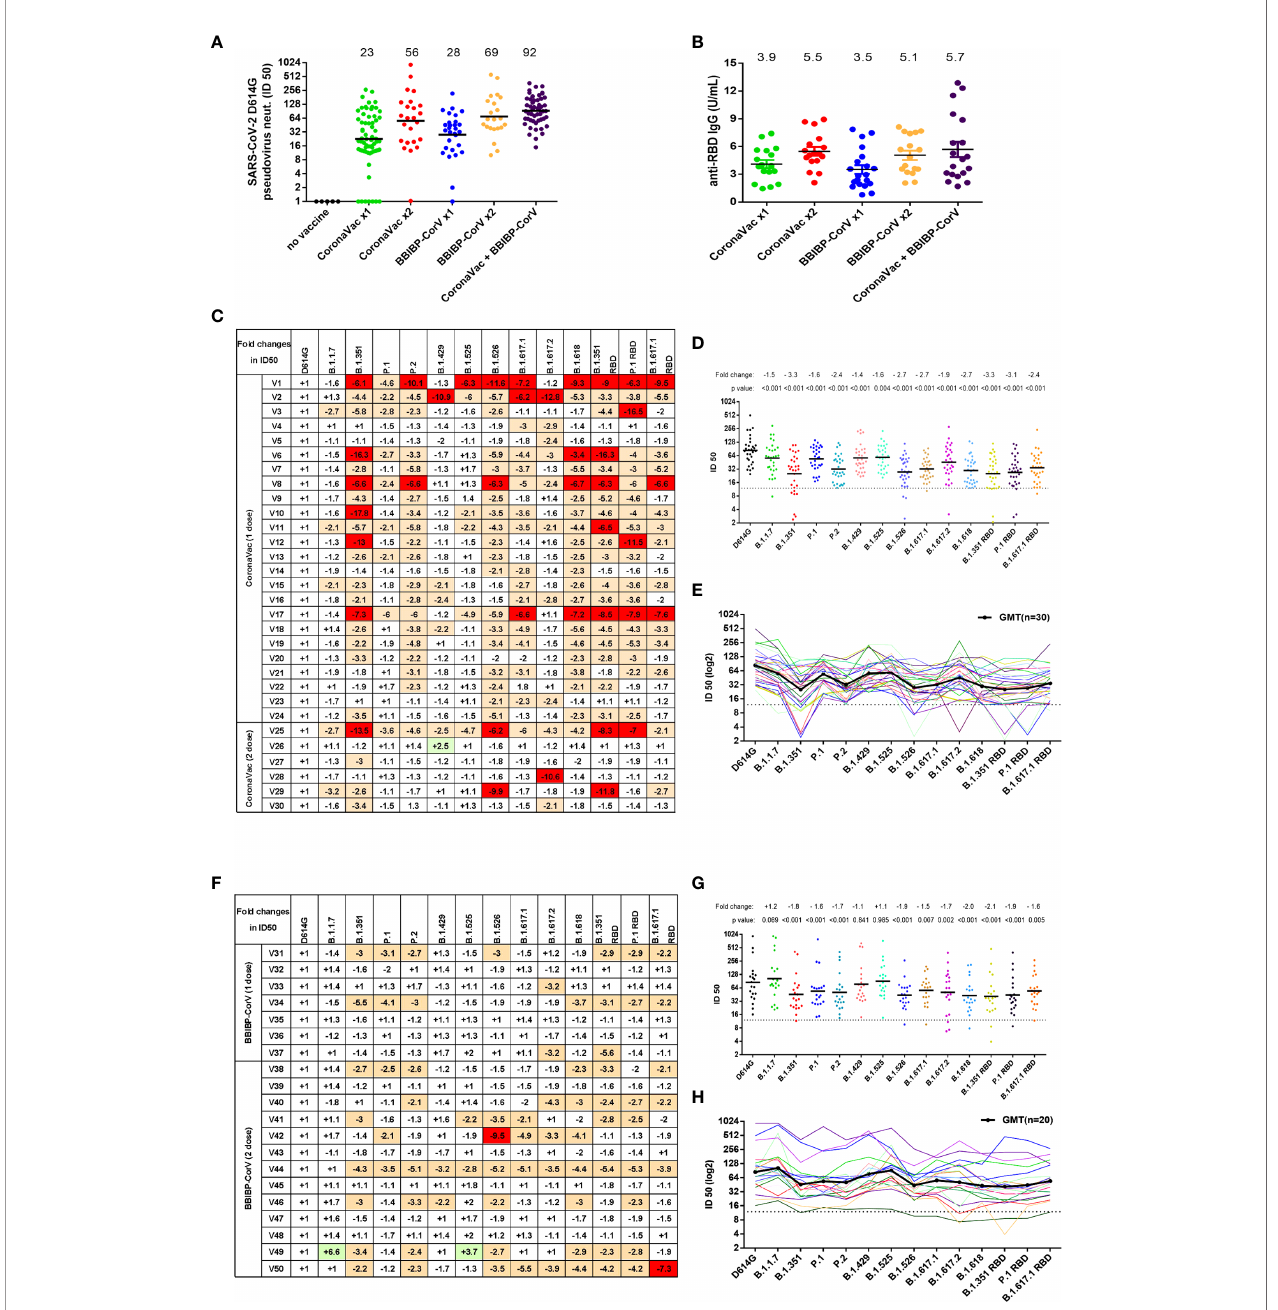
FIGURE 5 | Neutralization activity to SARS-CoV-2 variants conferred by vaccine sera (CoronaVac or BBIBP-CorV). (A) Neutralization ID50 values of the vaccinated sera against SARS-CoV-2 D614G reference pseudovirus. The black horizontal lines and the numbers over the lines indicate geometric mean titers. (B) Anti-SARS- CoV-2 RBD IgG antibody levels were measured by a quantitative ELISA against the wild-type RBD antigen. ELISAs were performed in duplicate, and average values were used. The black horizontal lines and the numbers over the lines indicate the average values of anti-SARS-CoV-2 RBD IgG. (C, F) SARS-CoV-2 variants reduced neutralization sensitivity to CoronaVac vaccine sera (C) or BBIBP-CorV vaccine sera (F) . Fold changes of vaccine sera neutralization activity (ID50) between variants and D614G reference strain pseudoviruses, depicted in a heat map. “ − ” represents the decrease of sensitivity of vaccine sera, and “ + ” represents the increase of sensitivity of vaccine sera. The values are marked in red, indicating that sensitivity is decreased at least 2-fold, while those in green indicate that sensitivity is increased at least 2-fold. (D, E, G, H) Neutralization ID50 values of the vaccinated sera [CoronaVac (D, E) or BBIBP-CorV (G, H) ] against SARS-CoV-2 variant pseudoviruses. The geometric mean titer against each variant is indicated by a black horizontal line in panels (D, G) and a black curve in panels (E, H) The fold changes of ID50 between variant and D614G pseudoviruses are illustrated by the overall average at the top in (D, G) . The dashed line represents the initial dilution of vaccine sera. Neutralization activity is de fi ned as the percent reduction in luciferase activity relative to the virus control wells (virus +